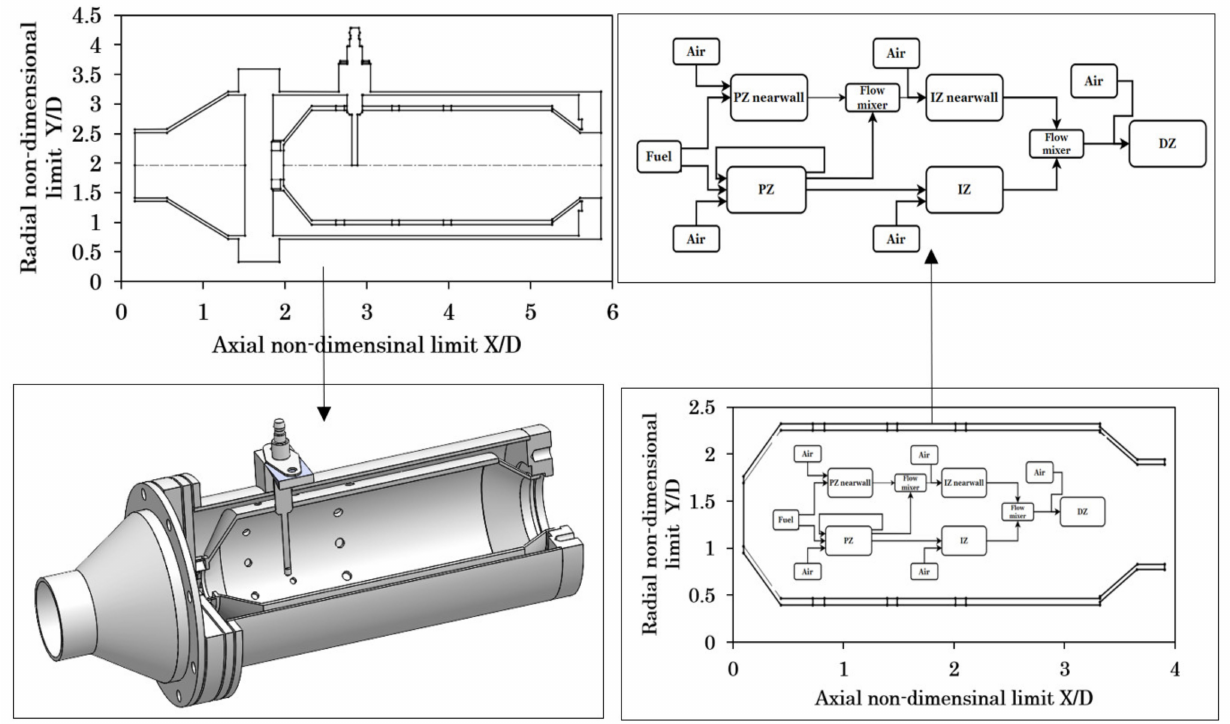
Figure 4. Combustor preliminary design results, reactor network, and the 3D CAD model.